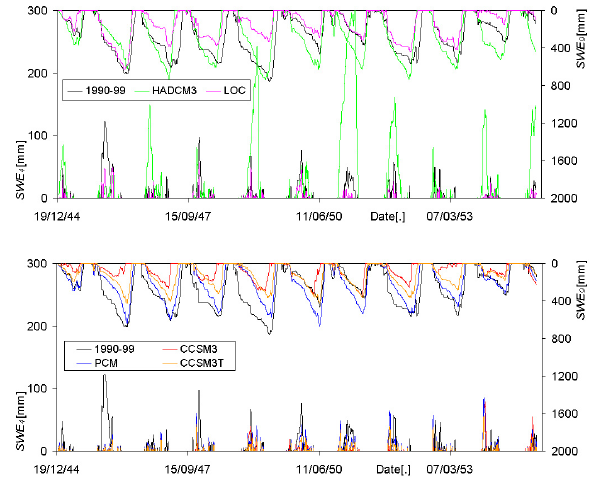
Fig. 6. Oglio at Sarnico. Scenario simulations, period 2045–2054. Snowpack SWE at belts 4 (1225ms.l.m.) and 9 (2975ms.l.m.). (a) LOC, HadCM3. (b) PCM, CCSM3, CCSM3T. Notice different scaling of left and right y-axis.